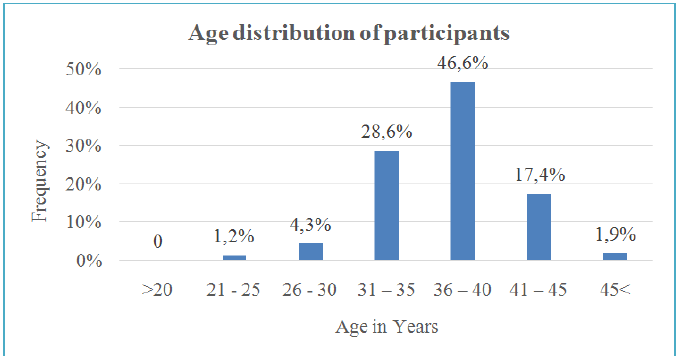
Fig. 2. Age distribution of